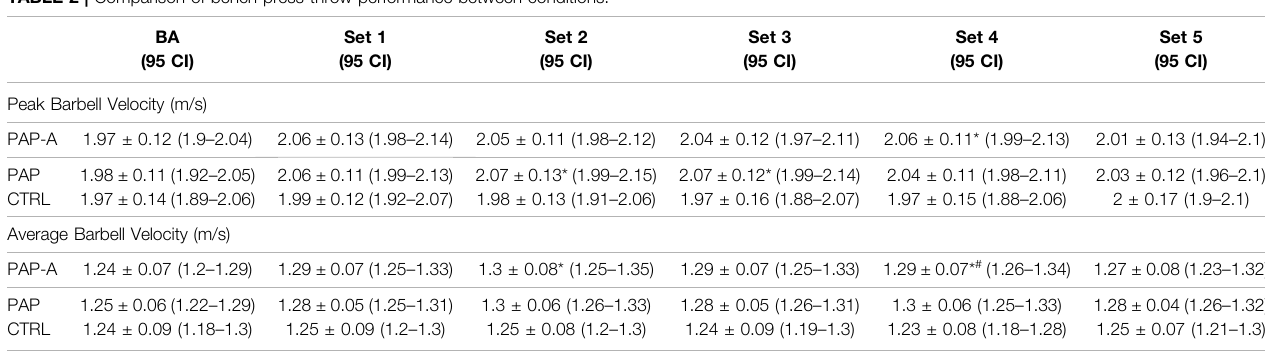
TABLE 2 | Comparison of bench press throw performance between conditions.